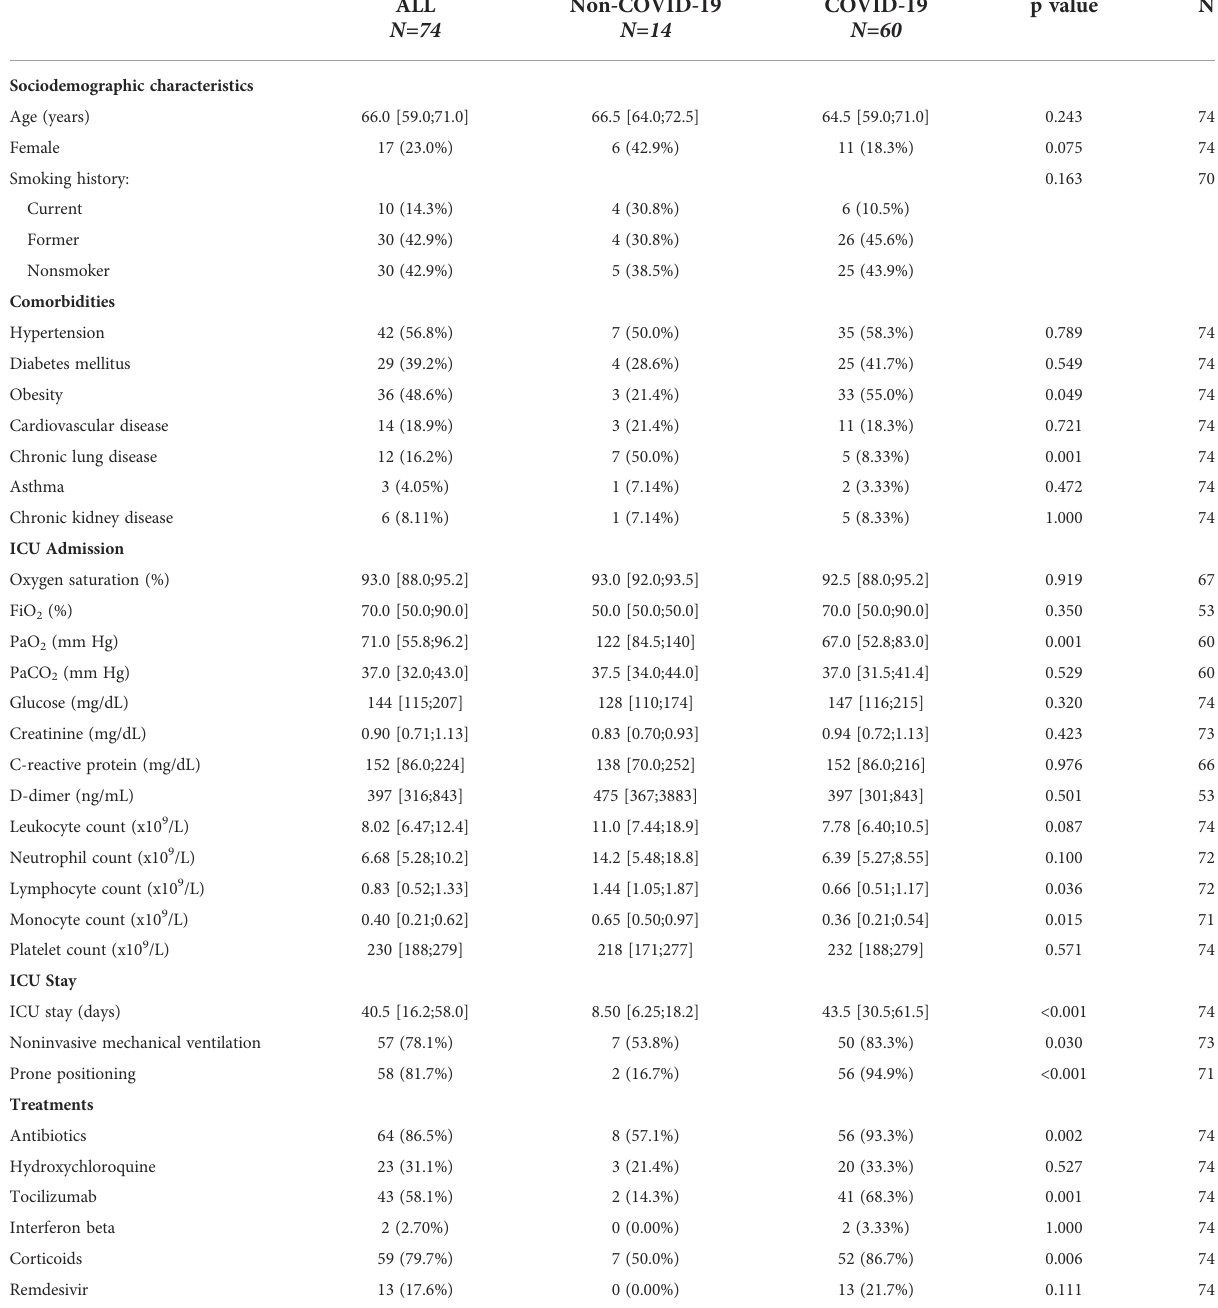
TABLE 1 Characteristics of patients with non-COVID-19 and COVID-19 ARDS (study population 1).